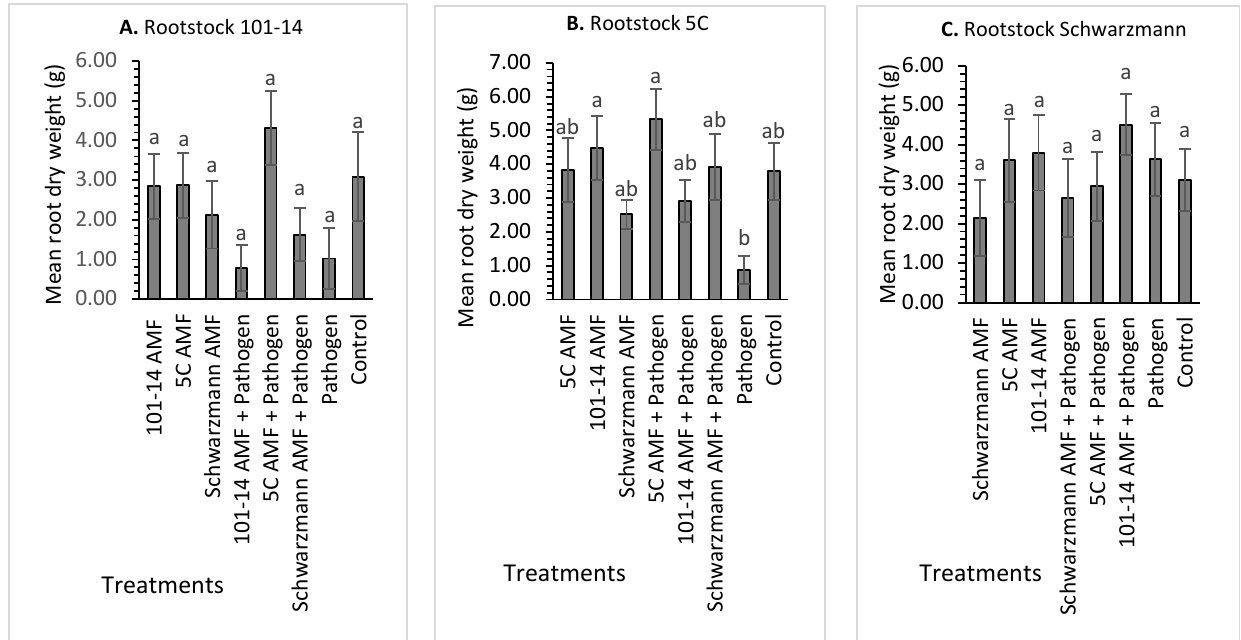
Figure 3. Mean root dry weight (g) at harvest for rootstocks 101-14 ( A ), 5C ( B ) and Schwarzmann ( C ) colonized with different AMF communities originating from different rootstocks (101-14, 5C and Schwarzmann) and inoculated with black foot pathogen isolates. Bars with different letters are significantly different ( p ≤ 0.05) based on the SED of mean comparisons generated from one-way ANOVA analysis in R. Error bars show ± SED.